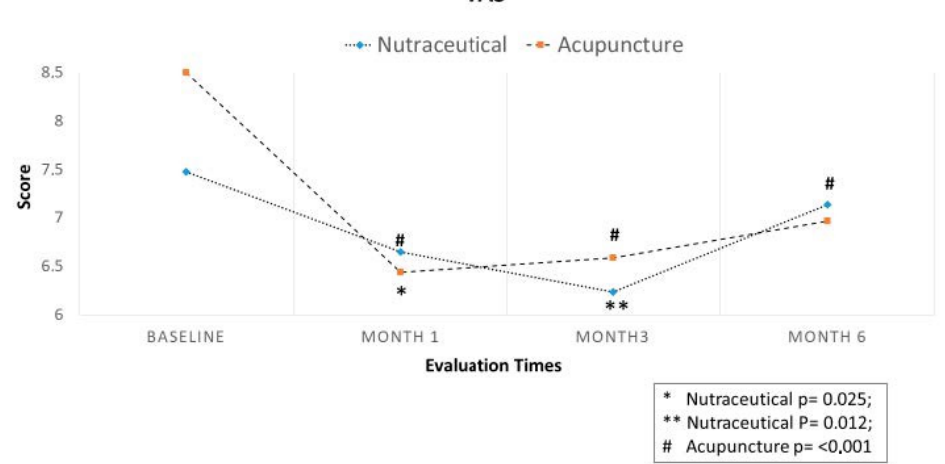
Figure 3. Primary efficacy end-point in analyzed populations: change in visual analog scale (VAS ) pain score during observation. The score evaluation shows a statistically significantly pain intensity reduction at all the observations except in Migratens ® Group at T3 (6 months and 3 months after treatment interruption according study protocol, p = 0.6).